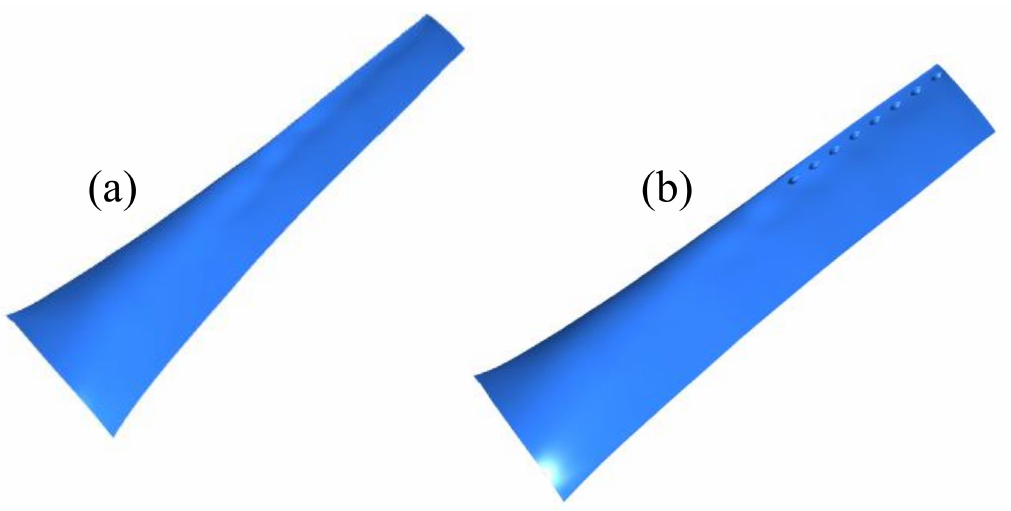
Figure 1. A CAD model of a steam turbine low-pressure last blade: ( a ) baseline geometry and ( b ) bionic tubercle